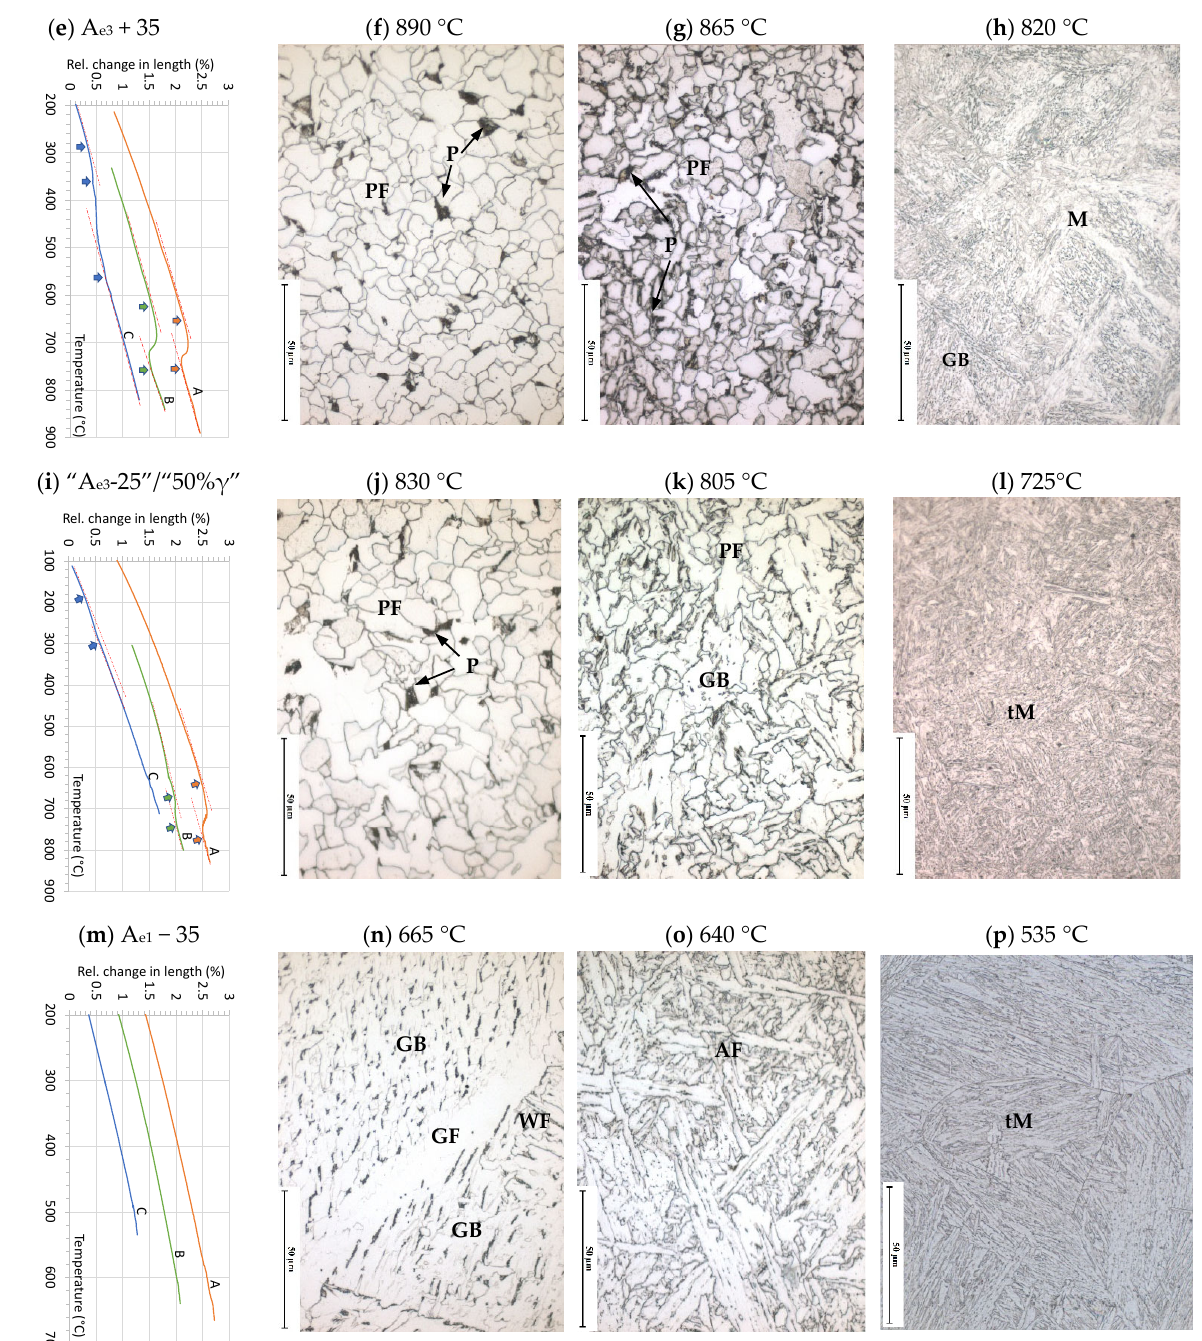
Figure 8. Dilatometric curves (the left column) recorded during the final cooling after applying schedule II (two cycles) with different reheating temperatures (T B ) on steels A, B and C together with the developed microstructure in the three alloys.